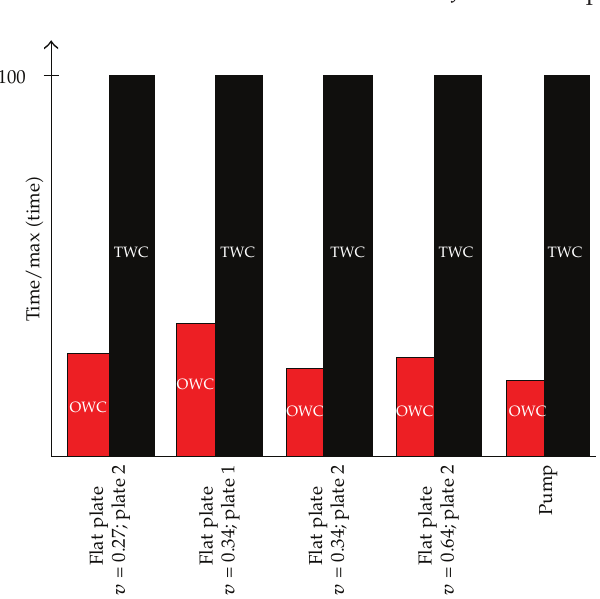
Figure 19: Solution time for one- and two-way